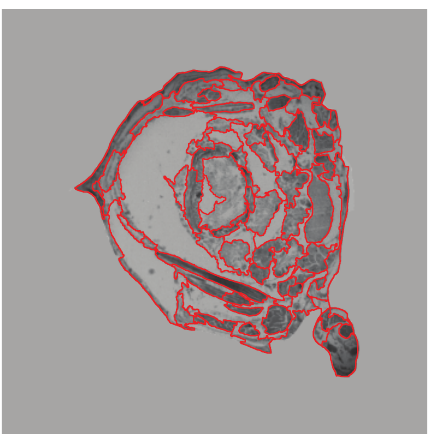
Figure 4: Locust’s coelom image segmentation results by the target controllable